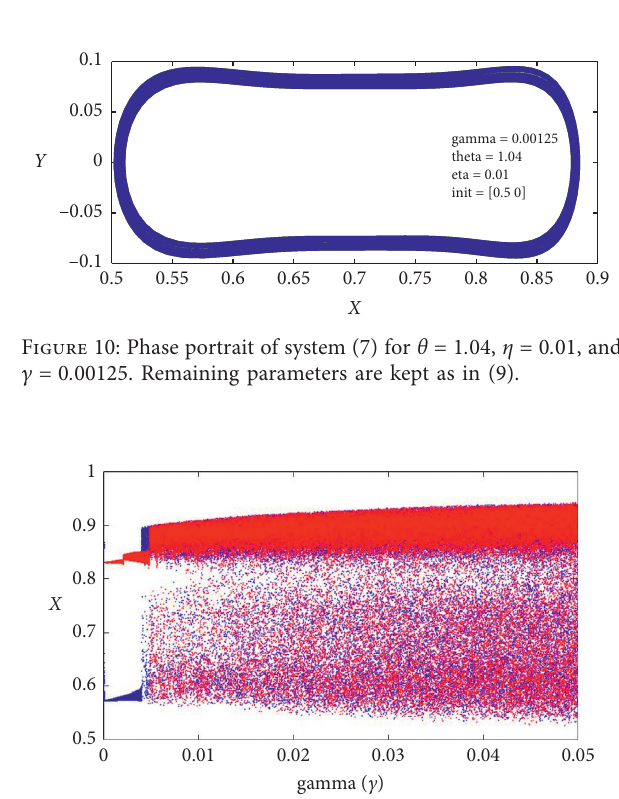
Figure 11: Bifurcation diagram for θ � 1 . 04 and η � 0 . 01 with the blue plots showing the forward continuation (increase the pa- rameter 0 ≤ c ≤ 0 . 05) and the red plots showing backward